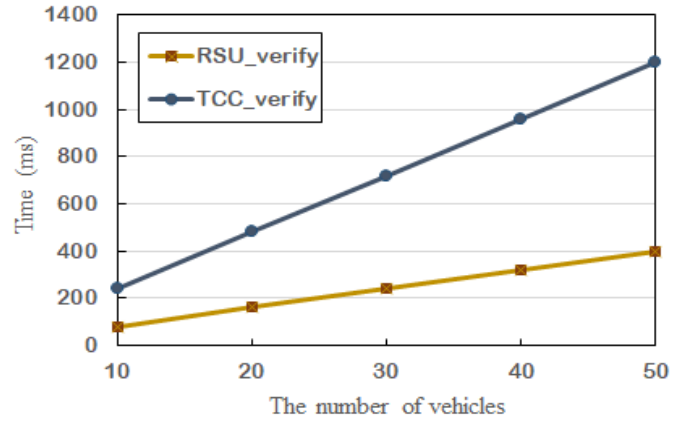
Figure 3. The time cost of signature verification.